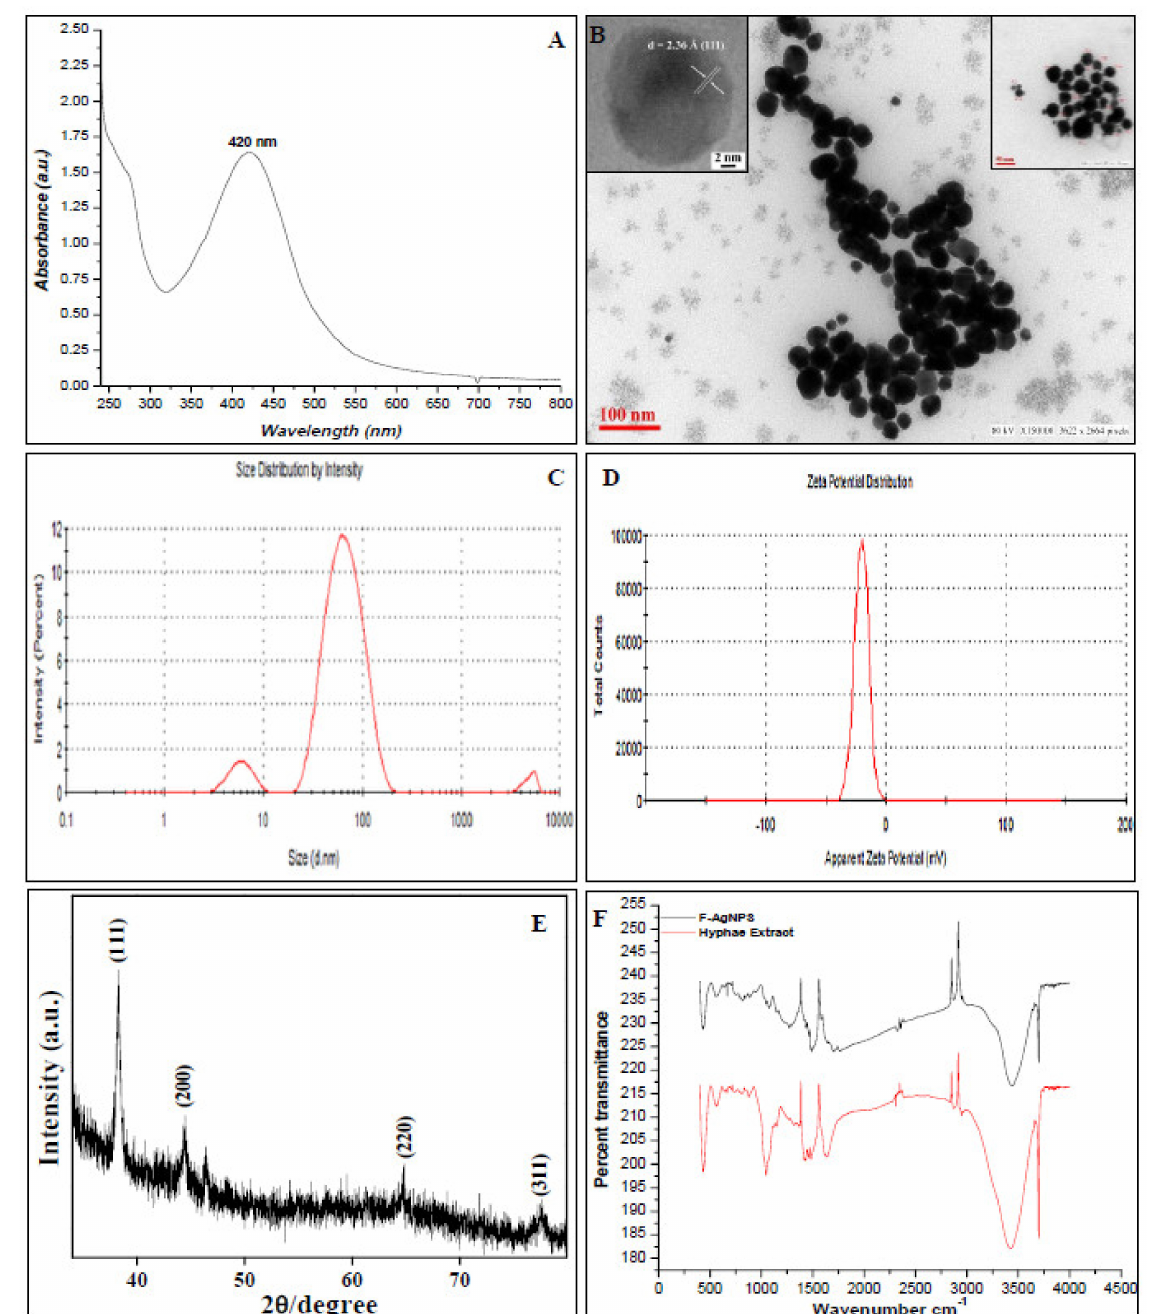
Figure 1. The physical characterization of F-AgNPs by ( A ) UV–visible spectroscopy ( λ Max 420 nm); ( B ) transmission electron microscopy (average size ~15 nm) HR-TEM and higher magnification in the insets; ( C ) dynamic light scattering (average size 47 d.nm); ( D ) zeta potential ( − 20.3 mV); ( E ) XRD and ( F ) FTIR